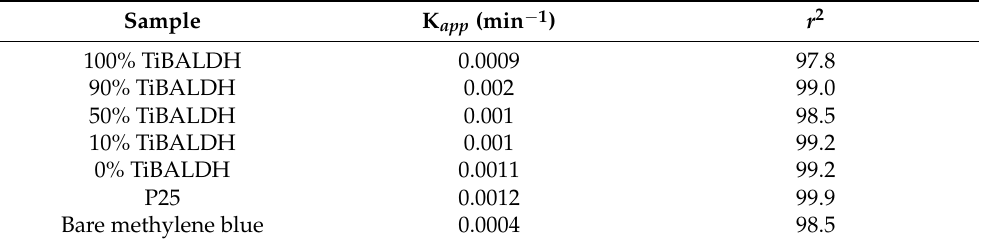
Figure 10. Photocatalytic activity of annealed fibers on methylene blue in visible light. Table 3. Values of rate constant and r 2 for the photocatalysis decomposition of methylene blue under visible light.